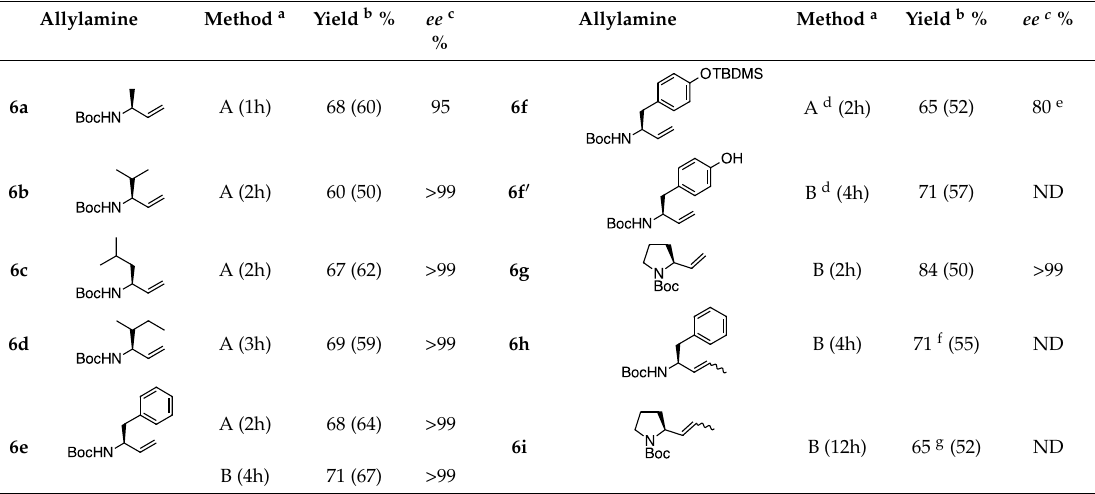
Table 3. Synthesis of allylamines 6 .